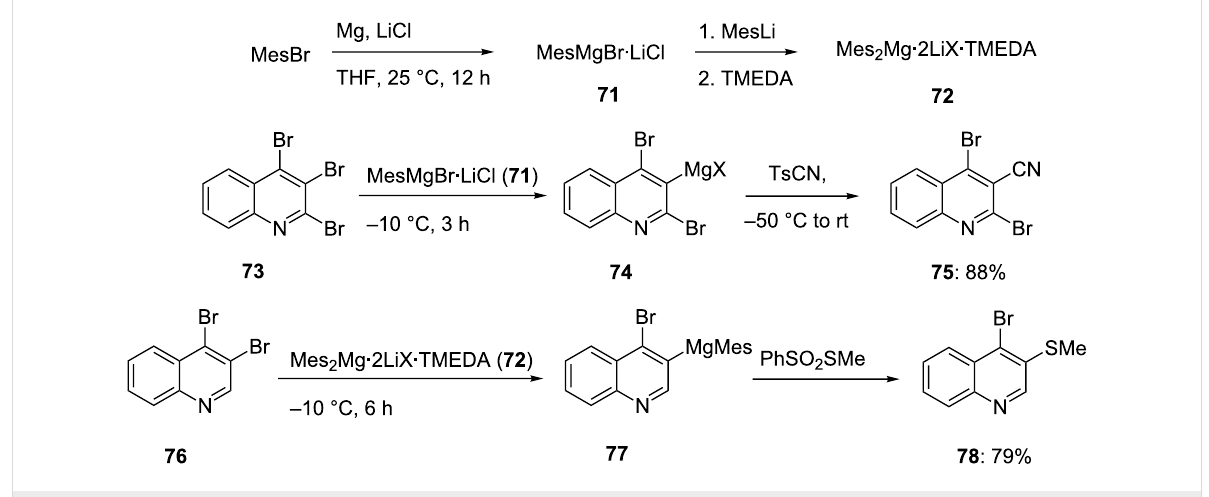
Scheme 13: Improved reagents for the regioselective Br/Mg-exchange on